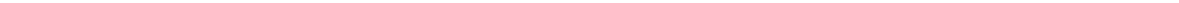
Fig. 4 Autophagy modulates PU.1 protein stability in T H 9 cells. a Naive CD4 + T cells were isolated from Atg5 fl / + *CD4-Cre and Atg5 fl / fl *CD4-Cre mice and differentiated into T H 9 cells for 24 h. Representative western blot of T H 9 cell-related transcription factors in Atg5 -de fi cient T H 9 cells compared to controls. Data are representative of two experiments. b Naive CD4 + T cells were isolated and differentiated into T H 9 cells for 24 h in the presence of metformin (1 mM) or chloroquine (25 µ M). PU.1, GATA-3 and β -actin expression was analysed by western blot and its quanti fi cation is shown in c . d Same as in b and Sfpi1 expression was determined by quantitative RT-PCR at 24 h from three experiments. e Naive CD4 + T cells were isolated and differentiated into T H 9 cells for 16 h in the presence or absence of chloroquine (25 μ M). Then, cells were treated with 25 μ g ml − 1 of DRB, an inhibitor of transcription, for 8 h. Sfpi1 mRNA expression was analysed by qRT-PCR at 0 and 8 h of DRB treatment and f PU.1 expression was analysed by western blot at 8 h of DRB treatment. Experiments performed twice. All qRT-PCR results were normalized to the expression of Actb (mean+s.d.), NS, not signi fi cant, analysis of variance (ANOVA) test. g Naive CD4 + T cells were isolated from Atg5 fl / + *CD4-Cre and Atg5 fl / fl *CD4-Cre mice and differentiated into T H 9 cells. PU.1 protein expression was assessed by western blot after being treated with 25 μ g ml − 1 cycloheximide to inhibit protein synthesis for 3, 6 and 12 h. PU.1 protein expression is plotted in h as a percentage of total PU.1 protein at time zero, and re fl ects the values obtained from western blot shown. The western blot shown is representative of two independent experiments. Mean (+s.d.), * P < 0.05 two-way ANOVA